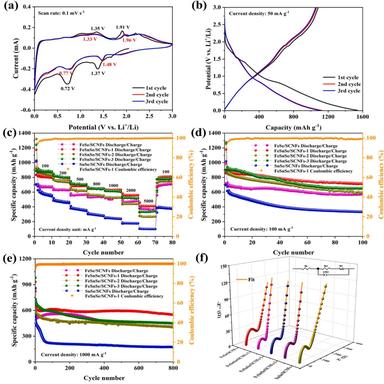
(a) Cyclic voltammetry curves of FeSnSe/SCNFs-1; (b) Charge/discharge curves of FeSnSe/SCNFs-1 at 50 mA g− 1 ; FeSe/SCNFs, FeSnSe/SCNFs-1, FeSnSe/ SCNFs-2, FeSnSe/SCNFs-3 and SnSe/SCNFs (c) multiplicity performance at 100 mA g− 1 to 5000 mA g− 1 ; (d) cycling performance at 100 mA g− 1 ; (e) cycling performance at 1000 mA g− 1 ; (f) EIS Nyquist plot.